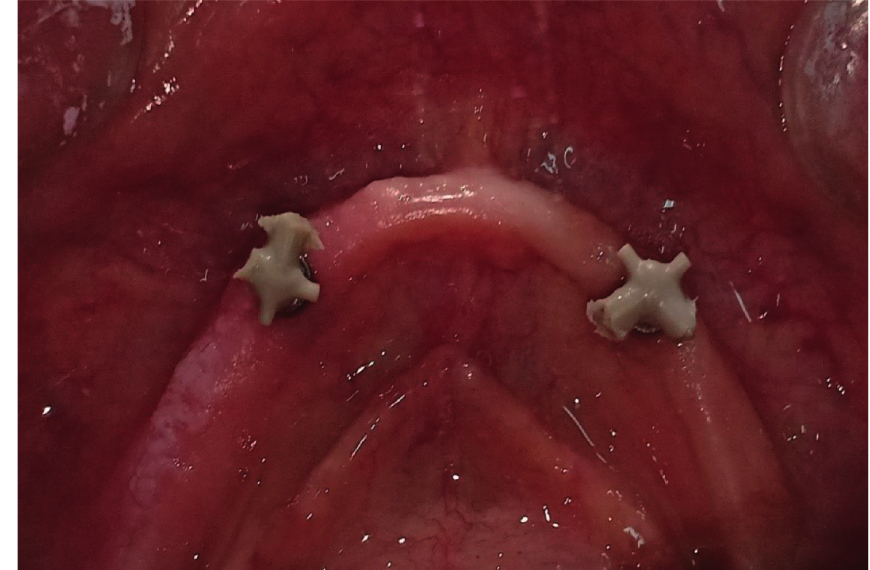
Figure 5: PEEK inserts attached to the ball